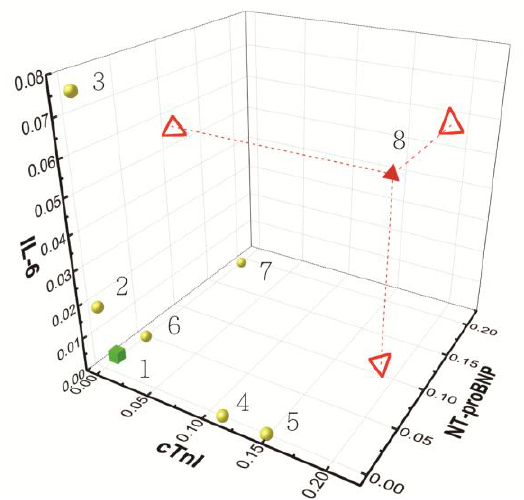
Figure 5. A presentation of the experimental results of biomarkers analysis in clinical human serums. The green cube represents the NDR of normal serum (Patient 1). The yellow spherical represents the NDR of a single heart disease (Patients 2–7). The red triangle cone represents the NDR of three heart diseases (Patient 8). The projected hollow triangles present the concentration in each biomarker.